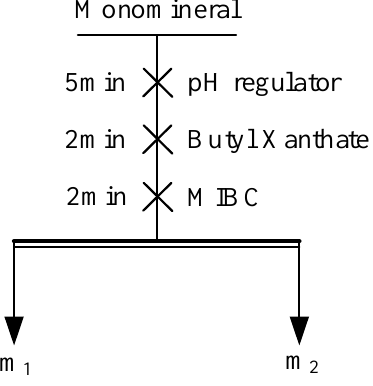
Figure 3. Flowsheet of flotation test.